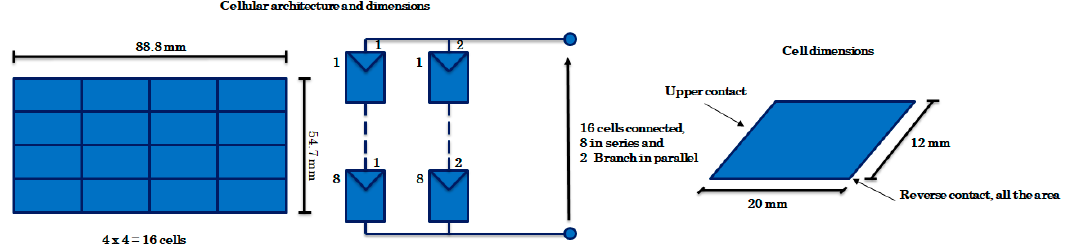
Figure 3. Cellular architecture and dimensions used.